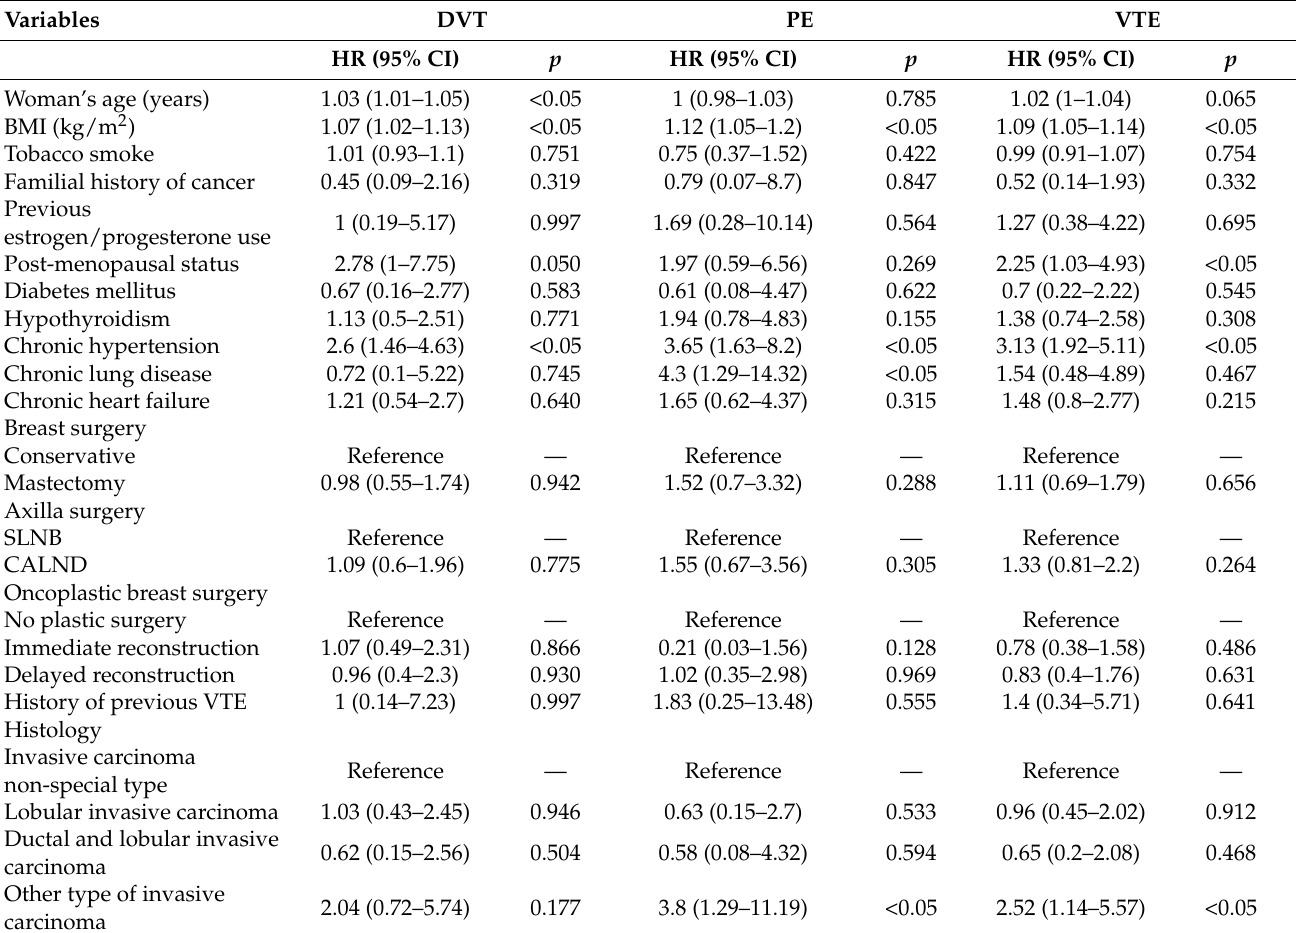
Table 4. Women characteristics and tumor histology considering only the sub-cohort of invasive breast tumors. Univariate Cox proportional hazards model analysis considering for new diagnosis of deep vein thrombosis (DVT), pulmonary embolism (PE), or venous thromboembolism (VTE) after breast surgery and possible associated factors.